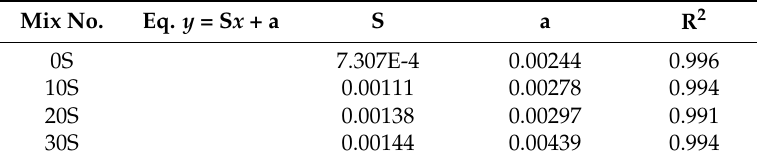
Table 5. Sorptivity values as obtained by experimental data fitted using equation 1.